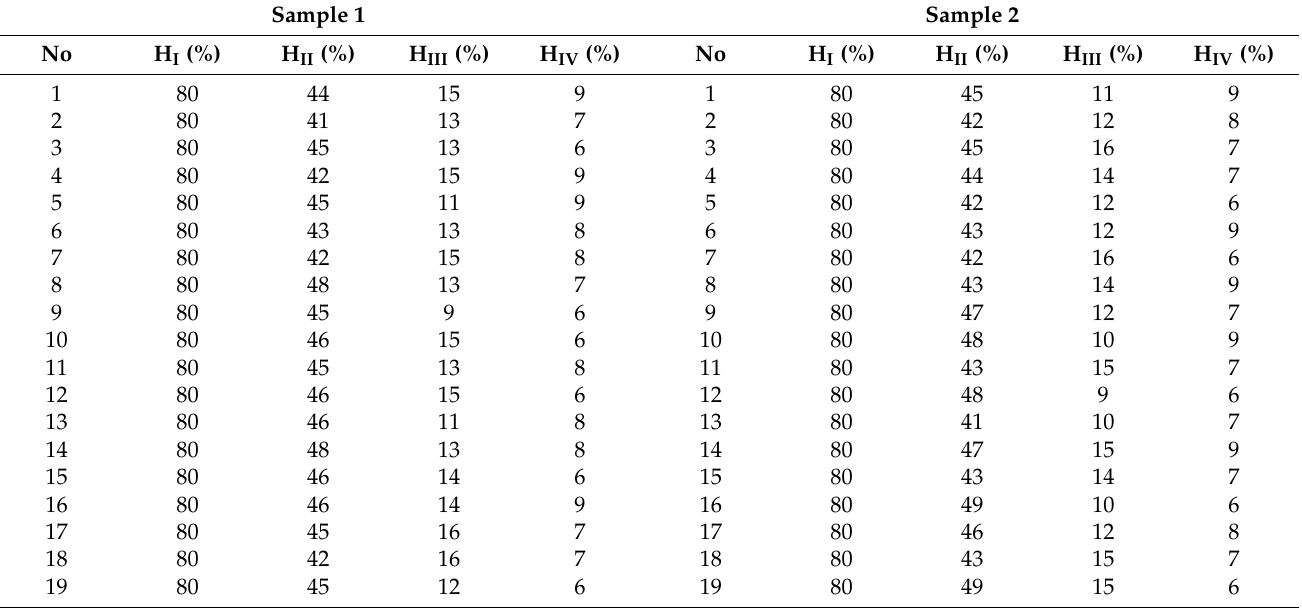
Table A3. Results of measurements of the homogeneity of selected acoustic properties of samples made using the additive manufacturing